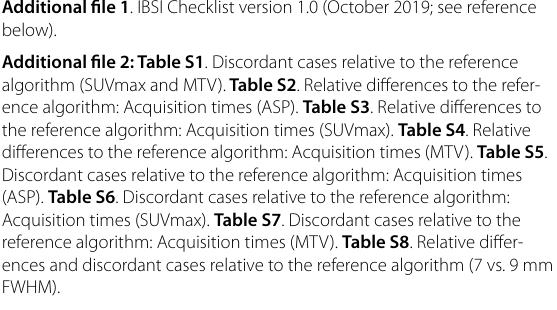
(ASP). Table S6 . Discordant cases relative to the reference algorithm: Acquisition times (SUVmax). Table S7 . Discordant cases relative to the reference algorithm: Acquisition times (MTV). Table S8 . Relative differ- ences and discordant cases relative to the reference algorithm (7 vs. 9 mm